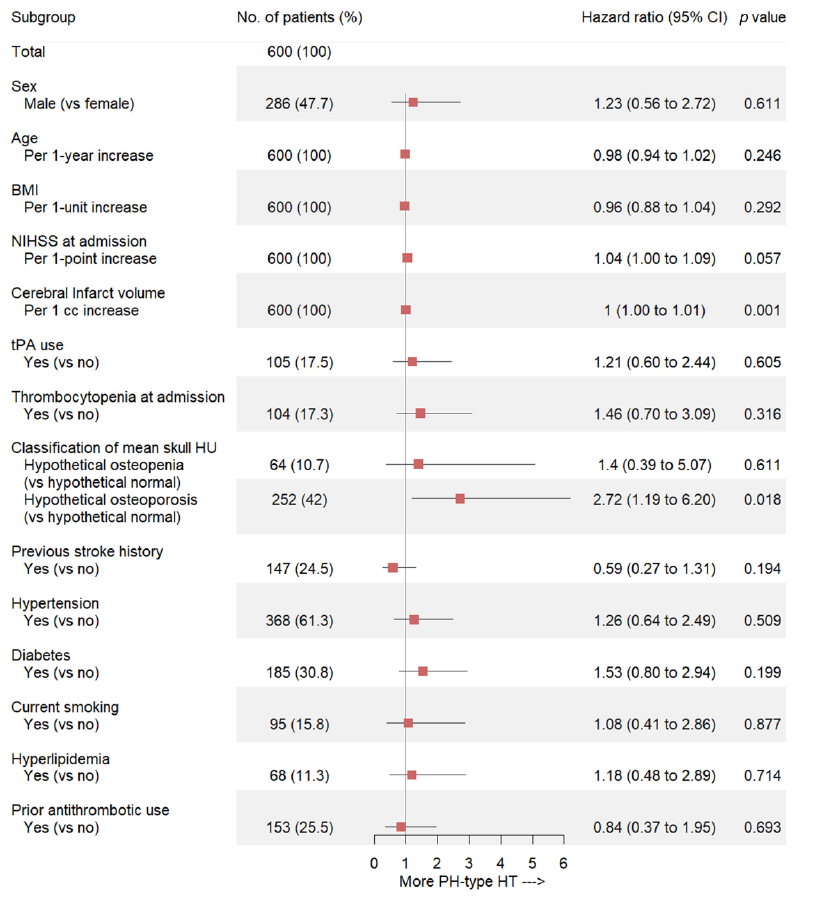
Figure 3. Forest plot of estimates from the multivariate Cox regression analysis to predict PH-type HT occurrence using potential predictive factors (adjusted for sex, age (continuous variable), BMI (continuous variable), NIHSS at admission (continuous variable), cerebral infarct volume (continuous variable), tPA use, thrombocytopenia at admission, classification of mean skull HU, previous stroke history, hypertension, diabetes, current smoking, hyperlipidemia, and prior antithrombotic use) in the study patients. PH = parenchymal hematoma; HT = hemorrhagic transformation; BMI = body mass index; NIHSS = National Institutes of Health Stroke Scale; tPA = tissue plasminogen activator; HU = Hounsfield unit.